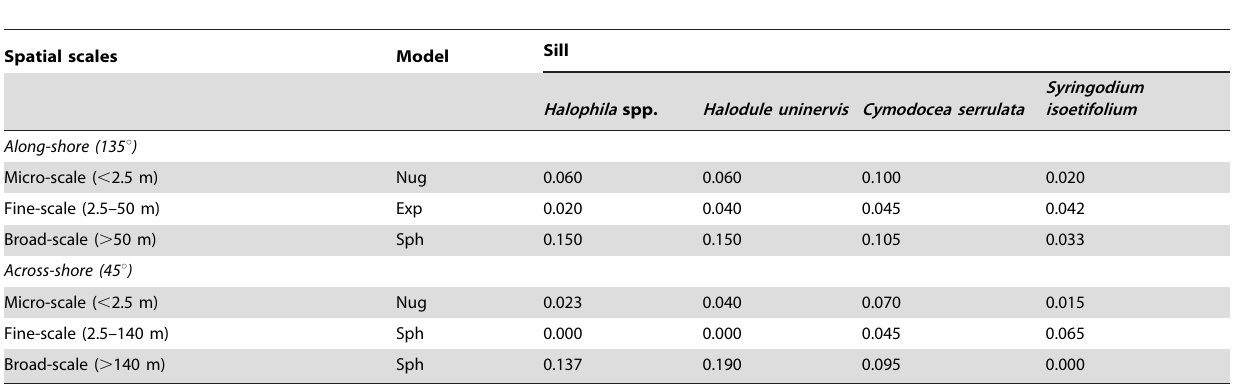
Table 3. Parameters of the linear coregionalization for four seagrass species in Pulau Tinggi, Malaysia in the two principal directions of continuity.